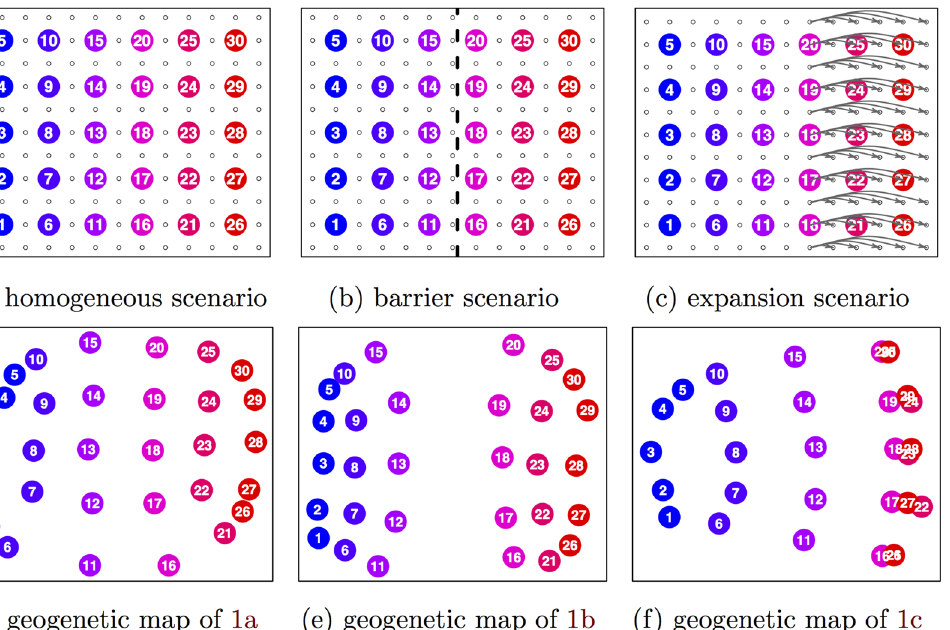
Fig 1. Simulation scenarios and their corresponding geogenetic maps estimated with SpaceMix. The smaller circles in the simulation scenarios represent unsampled populations. a) the configuration of simulated populations on a simple lattice with spatially homogeneous migration rates (a plot showing the first two Principal Component axes for this simulation is given in a); b) a lattice with a barrier along the center line of longitude, across which migration rates are reduced by a factor of 5; c) a lattice with recent expansion on the eastern margin; d) the maximum a posteriori (MAP) estimate from the posterior distribution of population locations under the scenario in 1a; e) MAP estimate of population locations under the scenario in 1b; f) MAP estimate of population locations under the scenario in